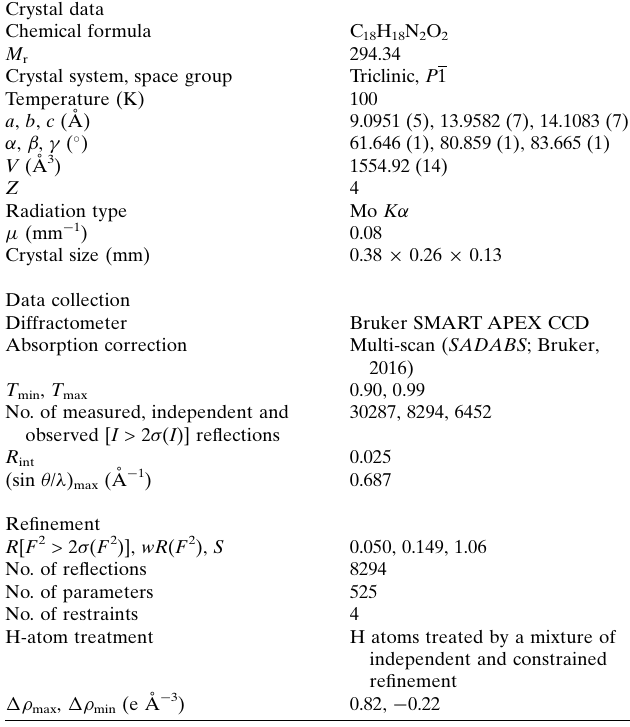
Table 2 Experimental